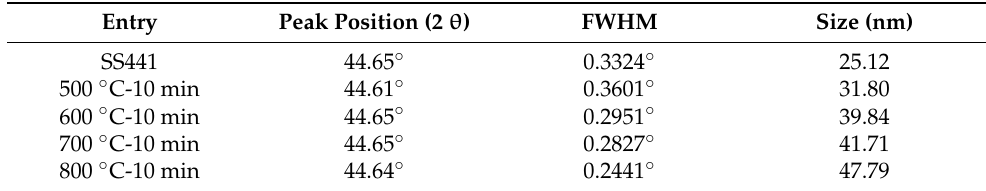
Table 3. XRD peak analysis with Scherrer’s equation.